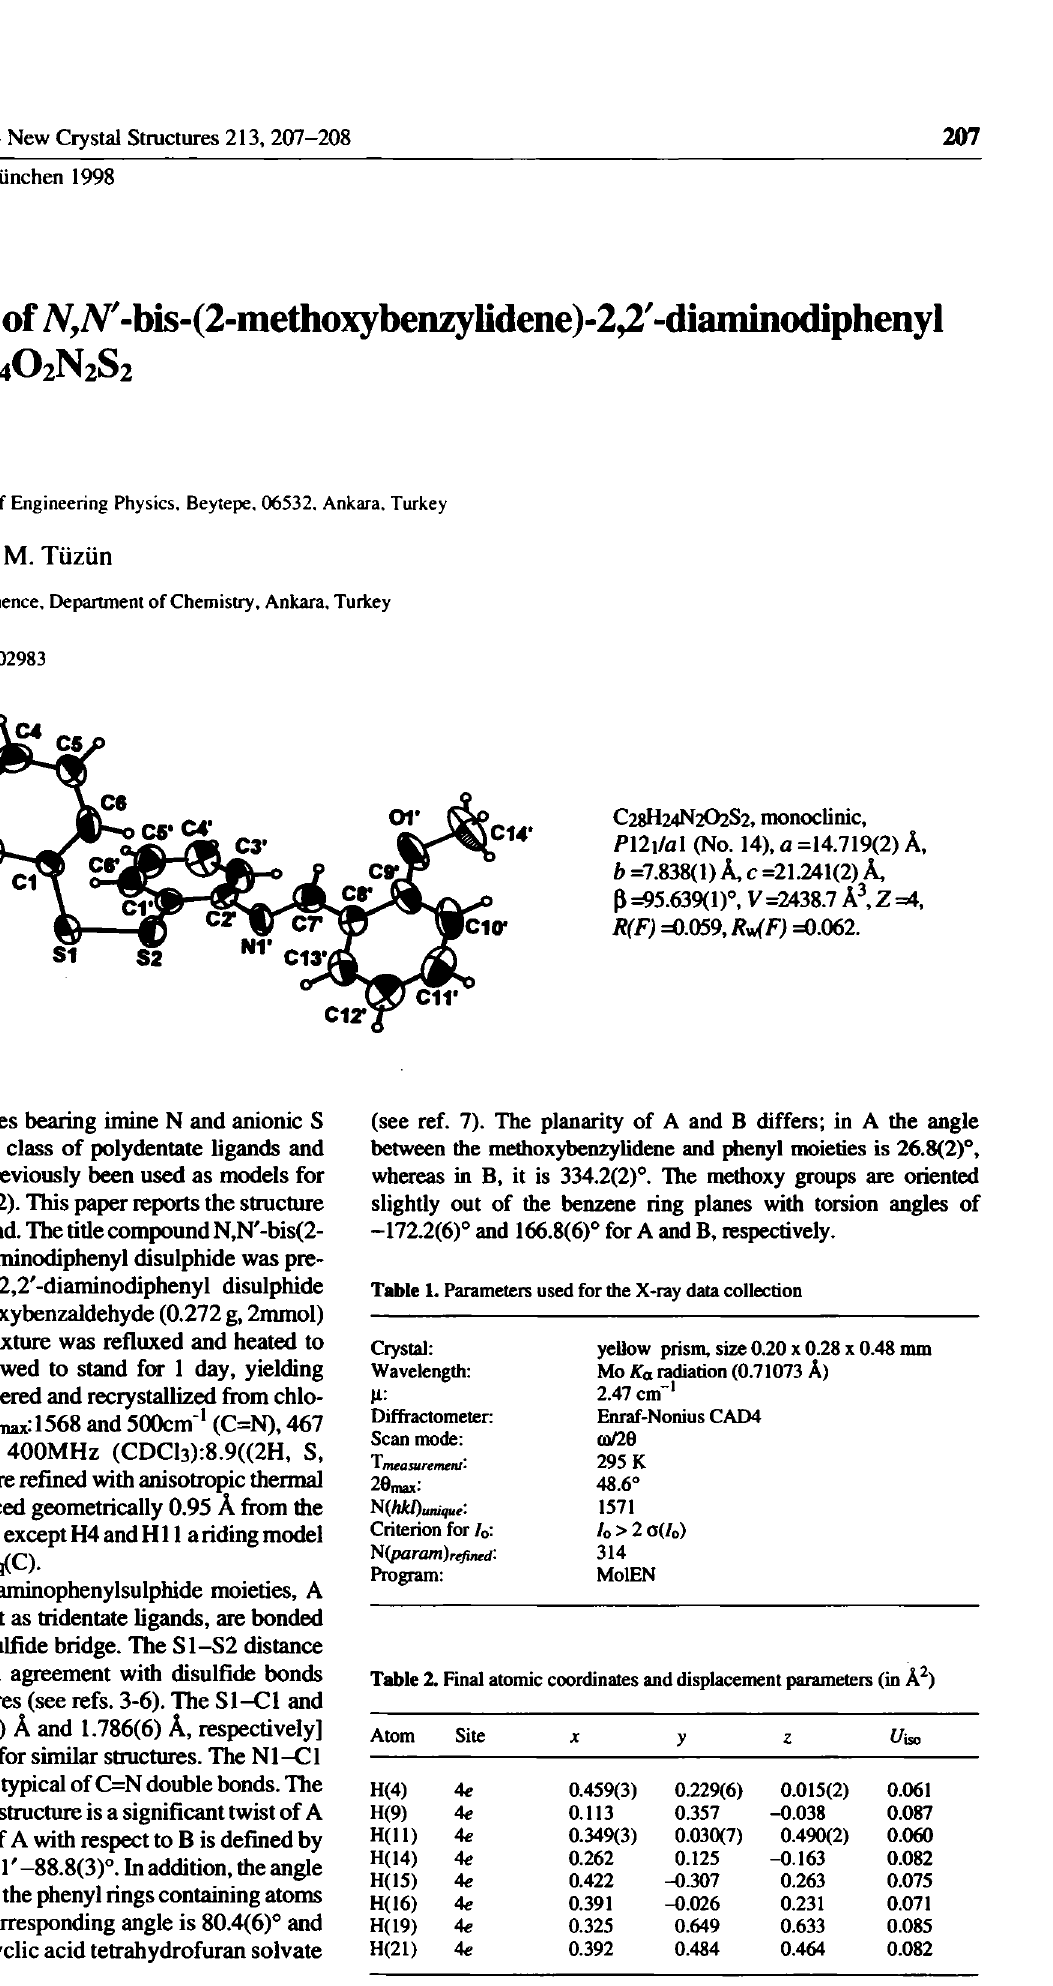
Table 2. Final atomic coordinates and displacement parameters (in Â^)